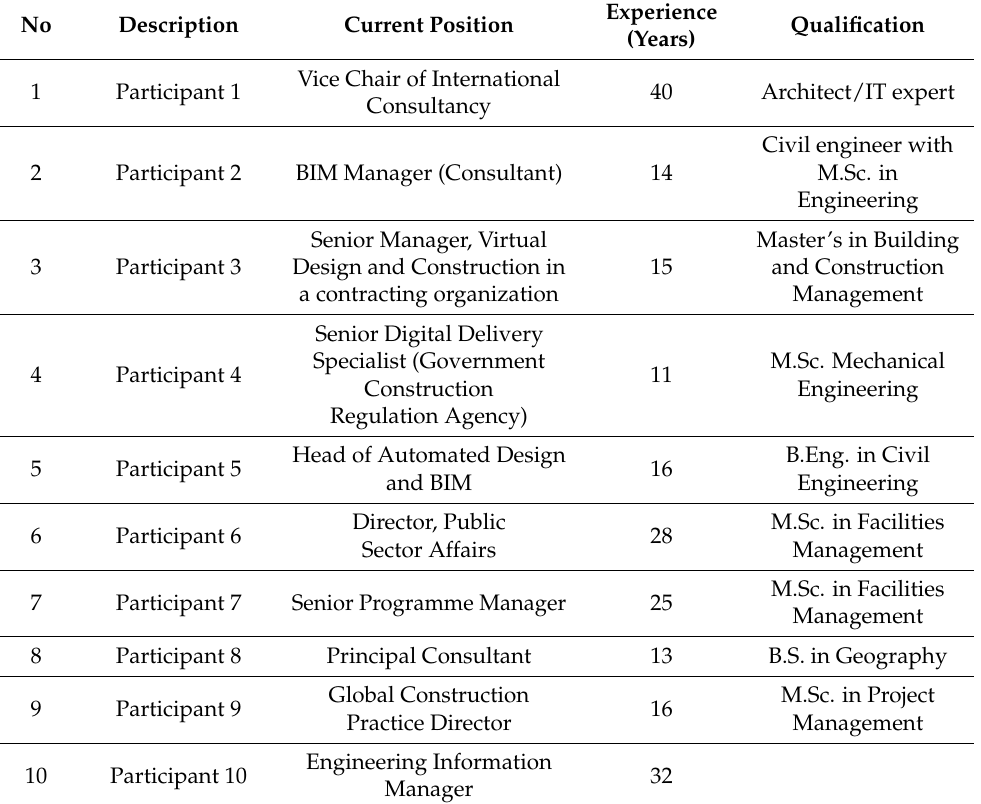
Table 1. Details of the